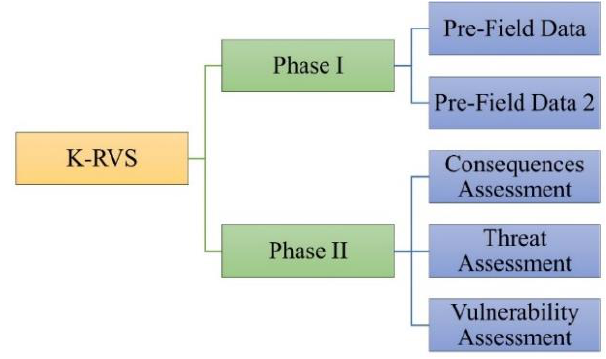
Figure 1. K-RVS components.